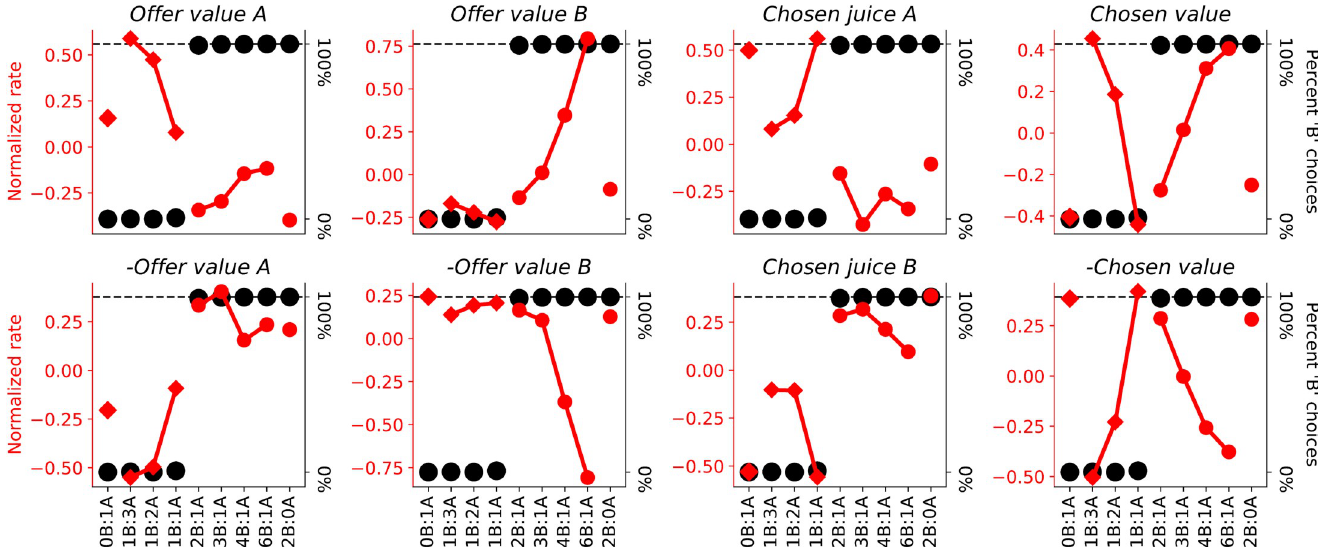
Fig 9. Tuning curves of post-juice response prototypes as defined by 8 cluster centers. The x-axis represents offer types ranked by the ratio #B:#A. The y-axis in red represents normalized response rates of pool 1. The y-axis in black shows monkey behavior. Encoded variables are denoted in the panel titles. Red diamonds represent the responses to chosen juice A whereas red dots represent the responses to chosen juice B. The separate red diamond and red dot show forced choices.